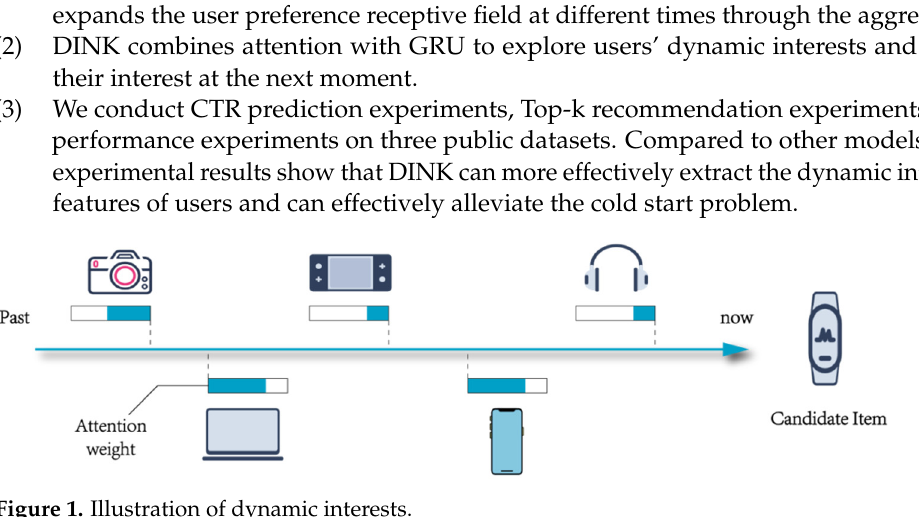
Figure 1. Illustration of dynamic